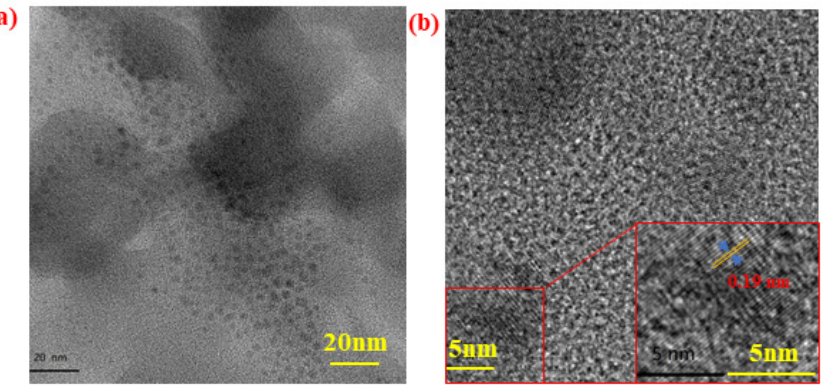
Figure 1. HR-TEM images of the synthesized C-CDs ( a ) and ( b ) and a zoomed-in image inside the red wireframe.